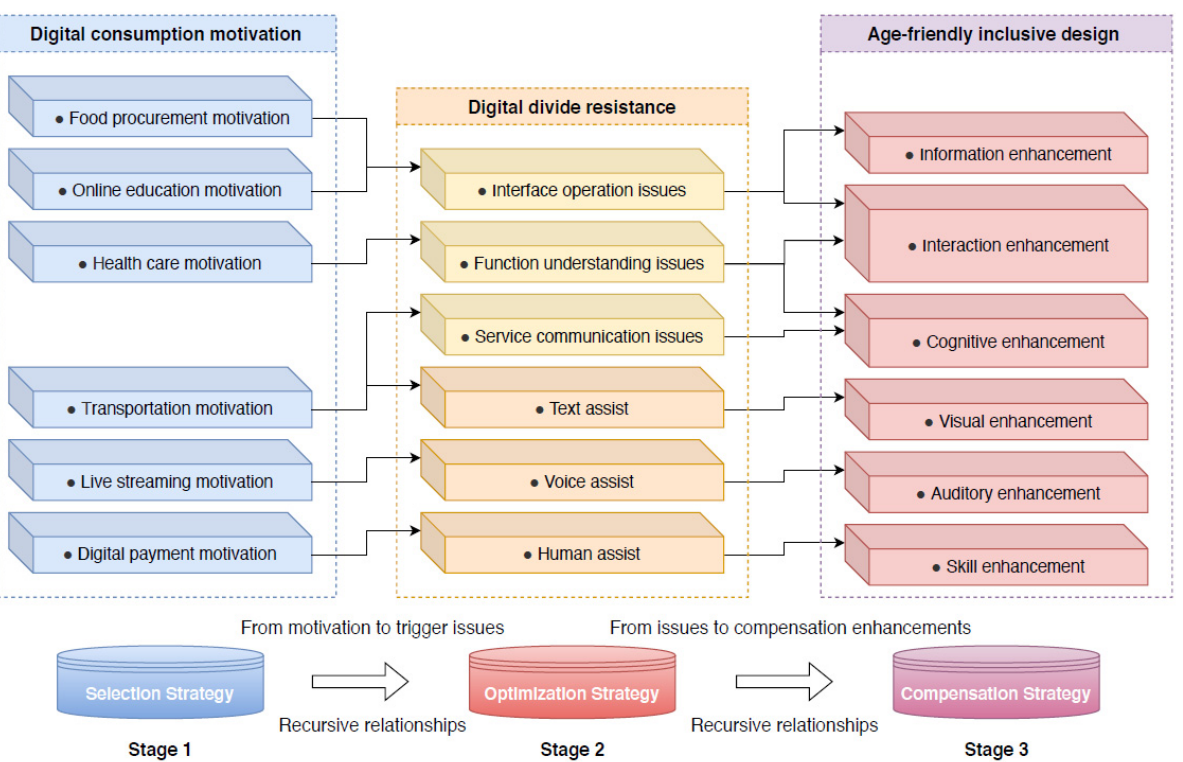
Figure 8. Semantic network relations of the digital consumption of older adults in a small-scale regional